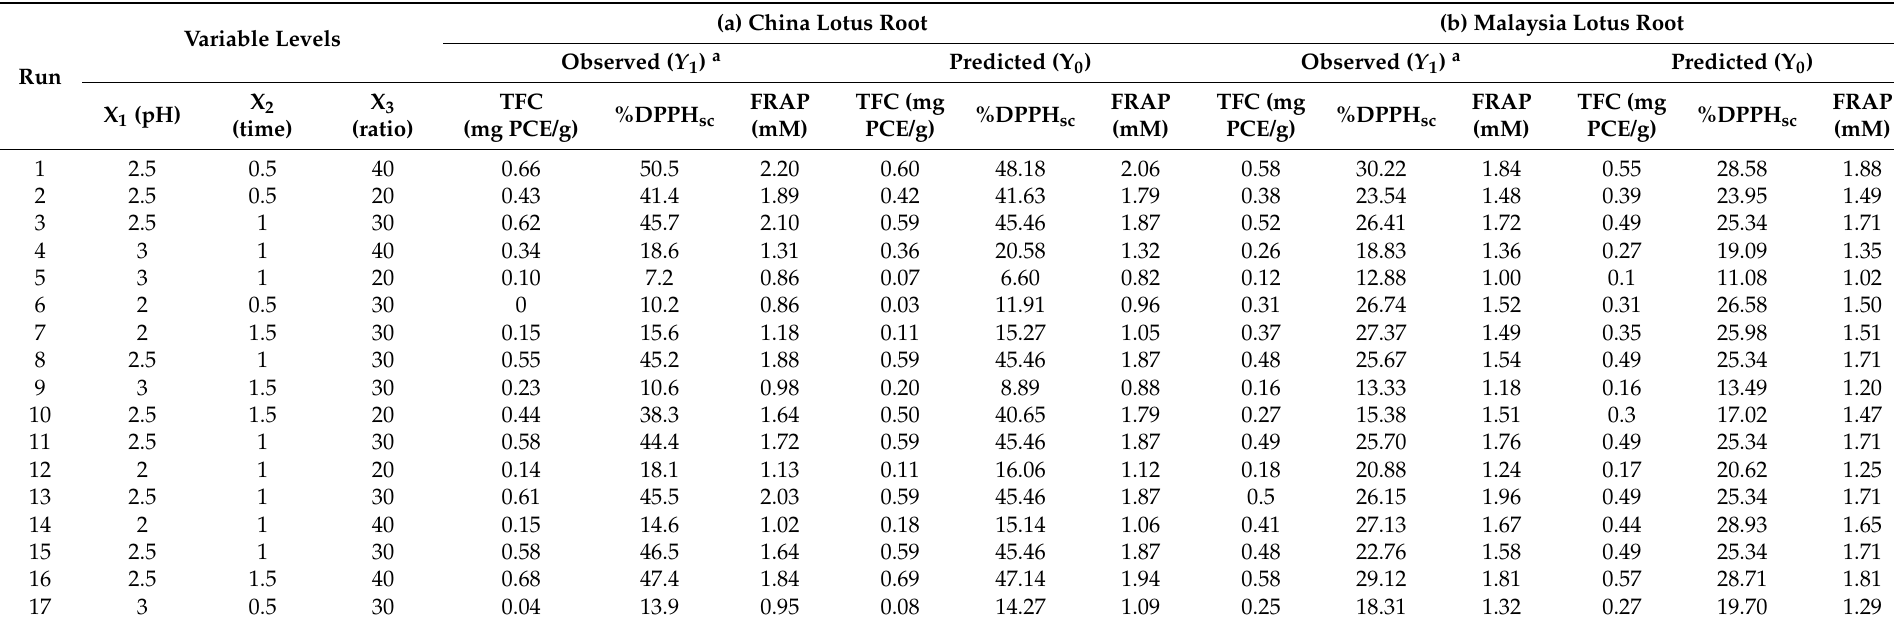
Table 2. BBD with the observed responses and predicted values for TFC (mg PCE/g), %DPPH sc and FRAP (mM) for (a) China lotus root and (b) Malaysia lotus root. Variable Run